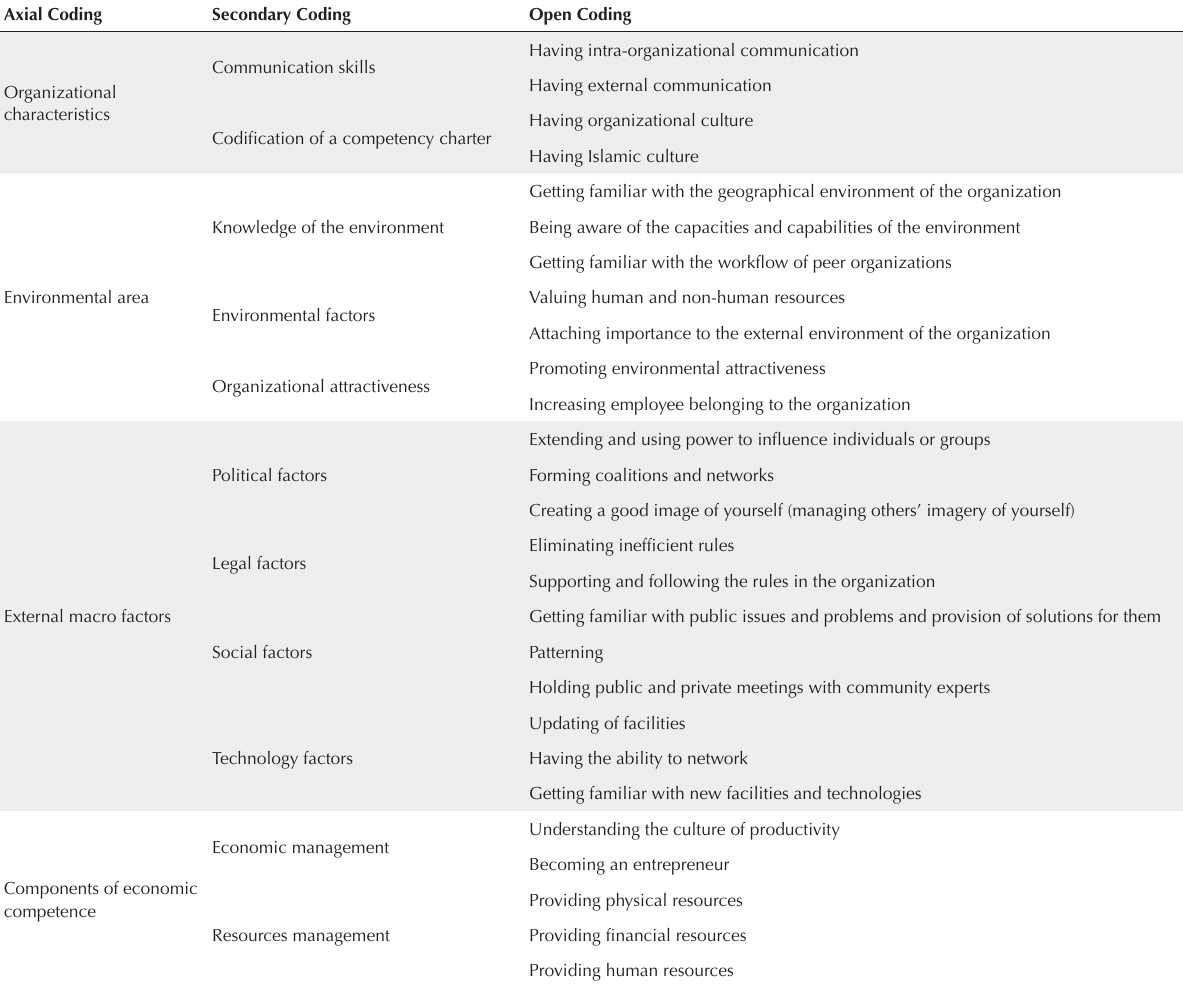
Table 2. Axial coding of qualitative data (contextual conditions) Axial